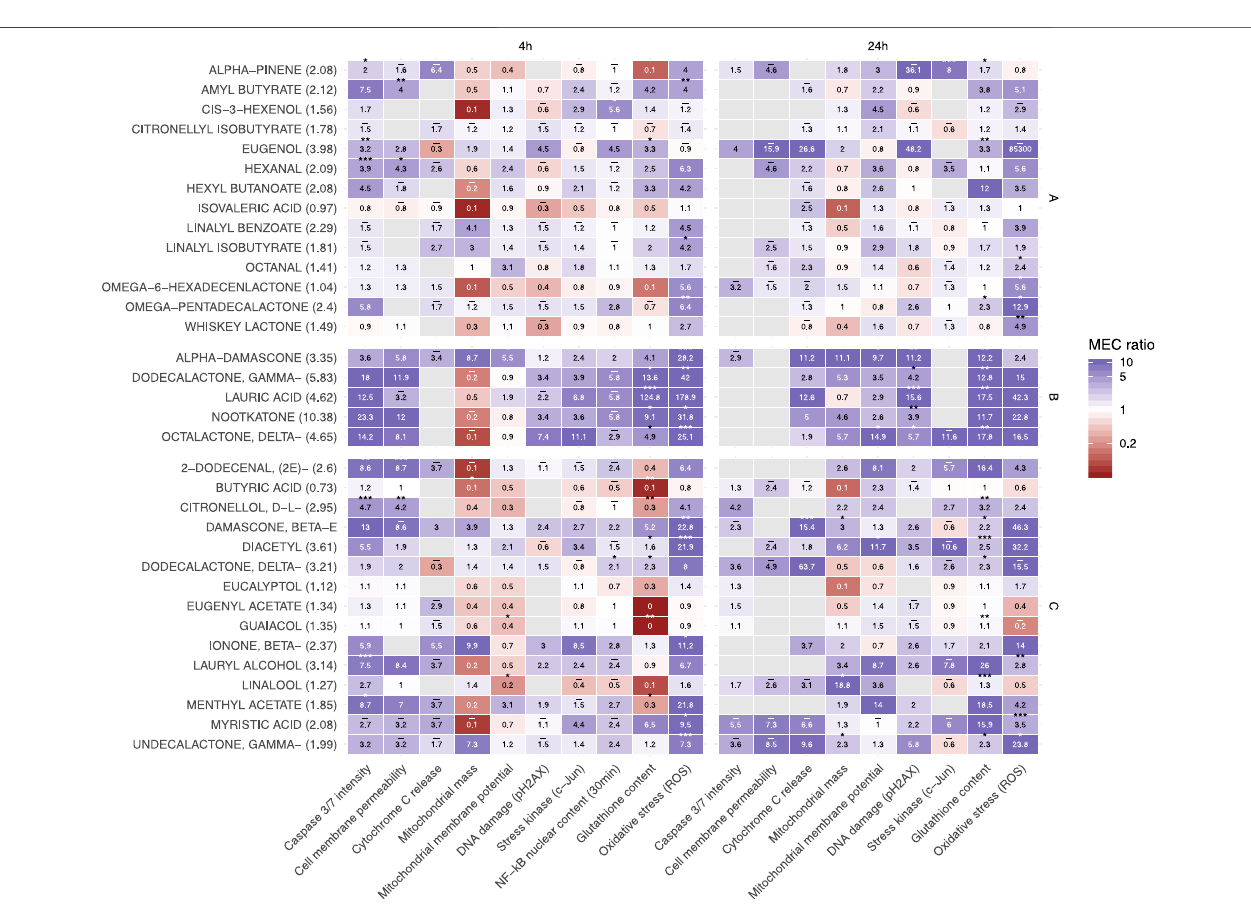
FIGURE 4 | Heatmaps of the HCS endpoints impacted by single fl avor ingredients tested after 30 min (only for NF-kB endpoint), 4 and 24 H exposure.